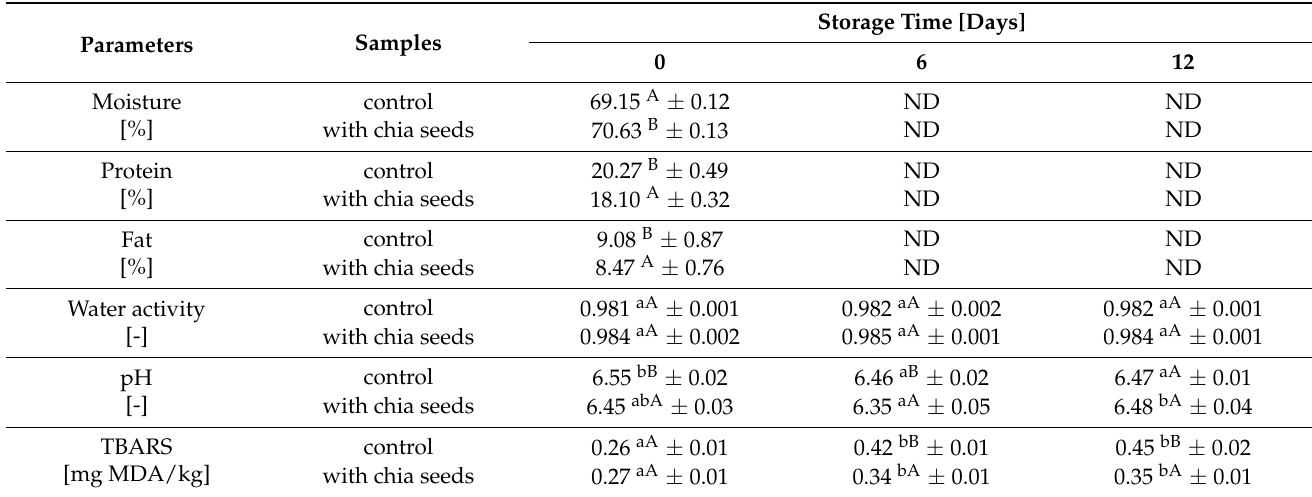
Table 1. Effect of chia seeds and storage time on the water activity, pH and TBARS of pork patties (mean ± SD).